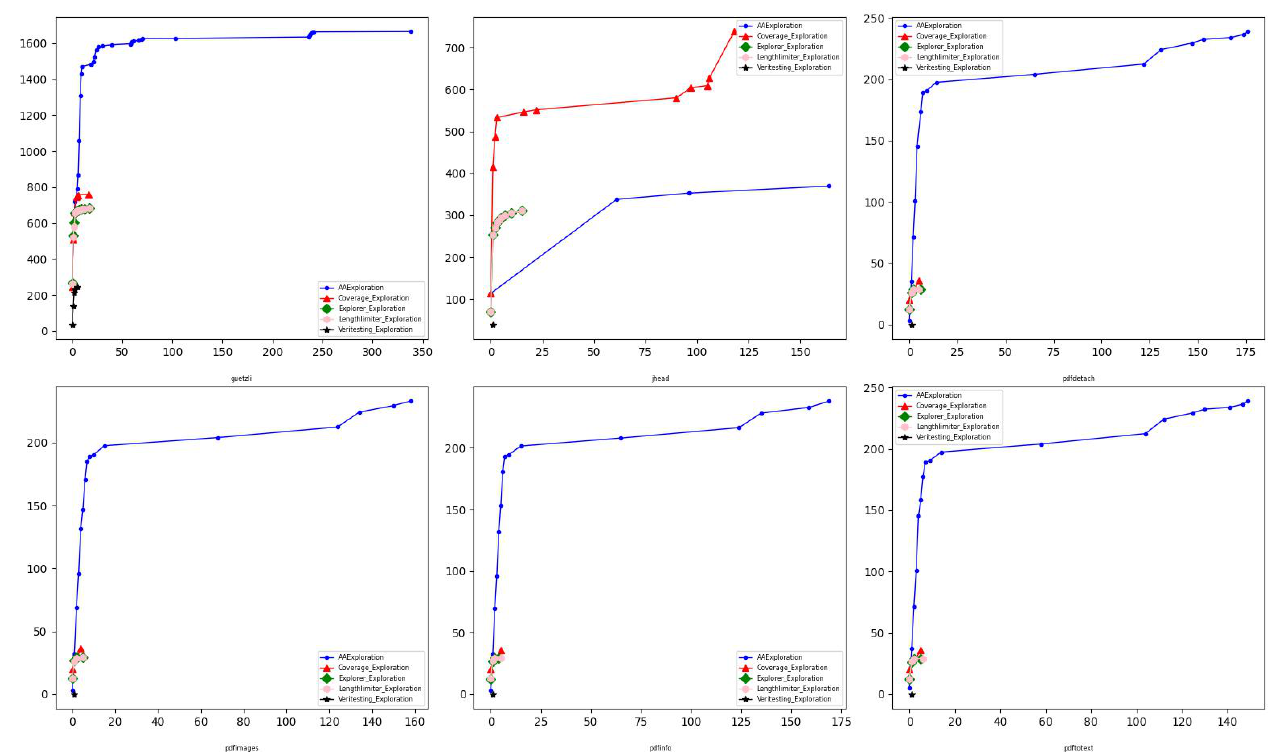
Figure 6. Improvements in path exploration capability (edge coverage) when exploring programs that cause state space